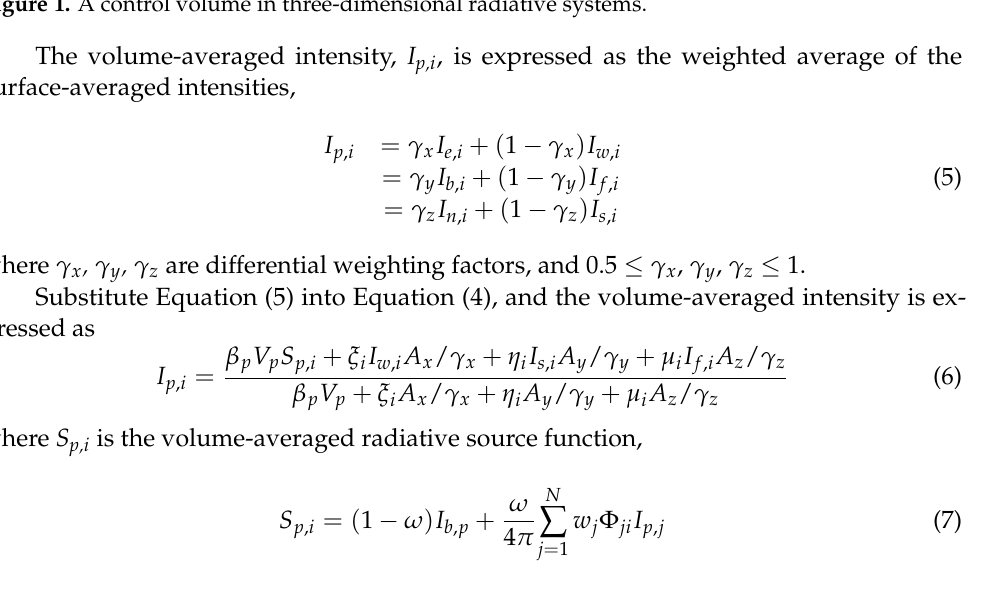
Figure 1. A control volume in three-dimensional radiative